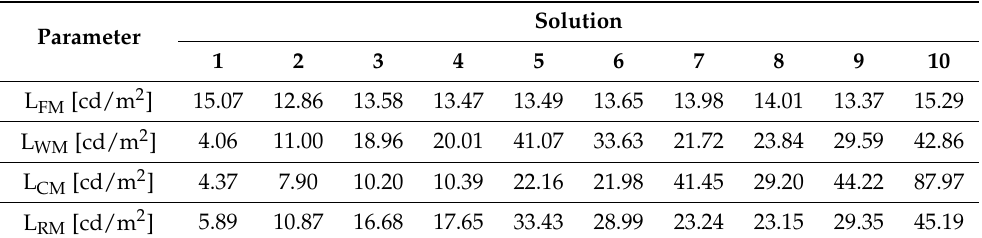
Table 3. The measured values of the mean luminance [cd · m − 2 ] of the corridor image presented on the computer screen in the box for group